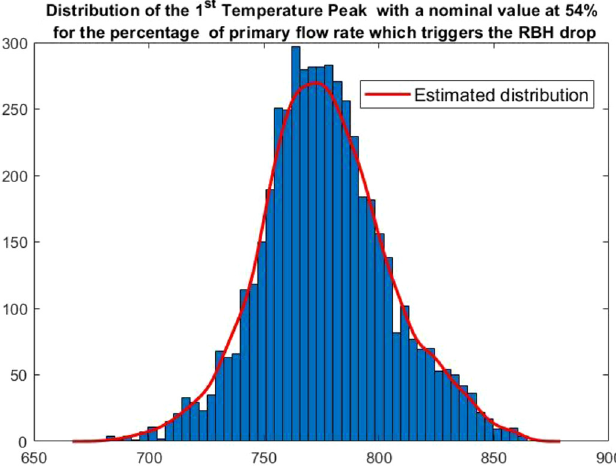
Fig. 8. Distribution of the 1 st temperature peak with the new criterion for RBH